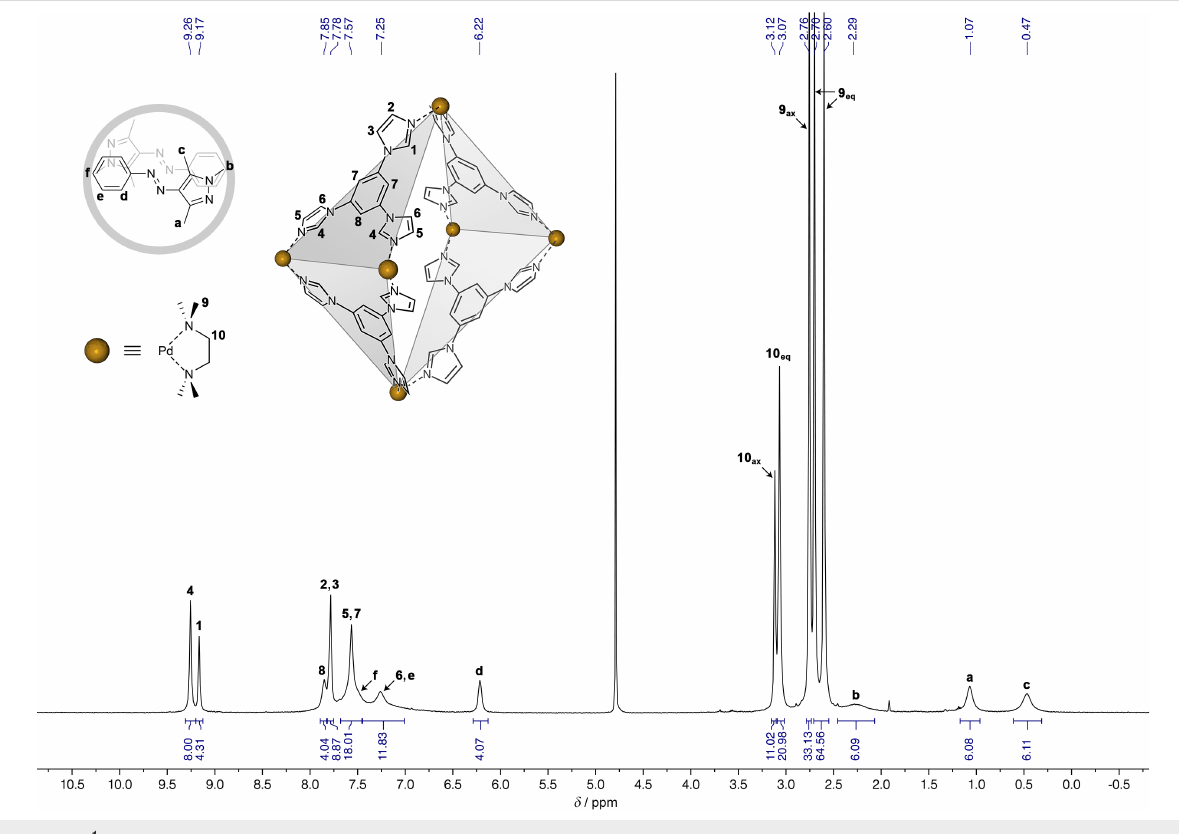
( E - 1 ) 2 2 crystallizes in the monoclinic space group P 2 1 / c , with one molecule of 1 and a half-molecule of 2 in the